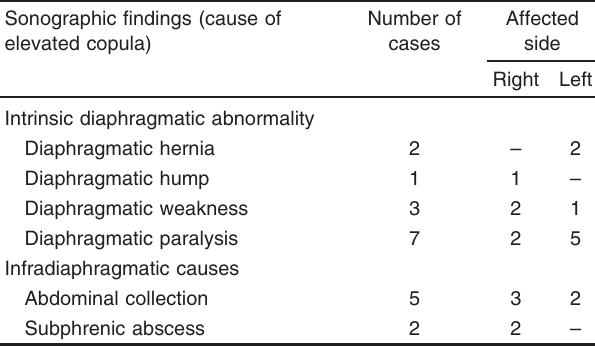
Table 2 Causes of elevated diaphragmatic copula among the study patients Sonographic findings (cause of elevated